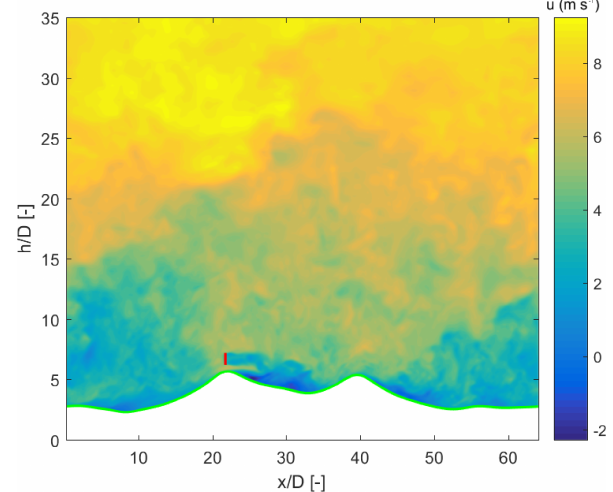
Figure 2. Instantaneous velocity in the streamwise direction along the main transect with turbine (in